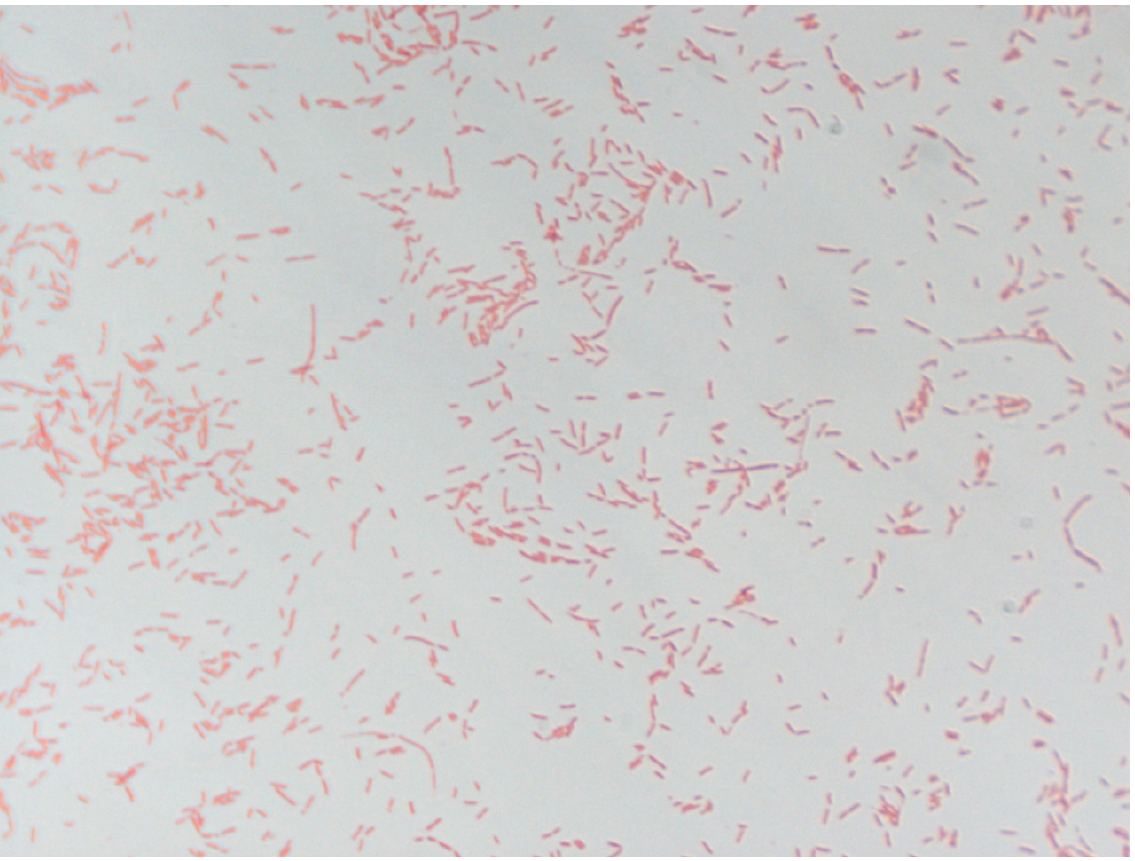
Figure 4. Gram staining of the strain Marseille-Q2390 at 100× magnification.